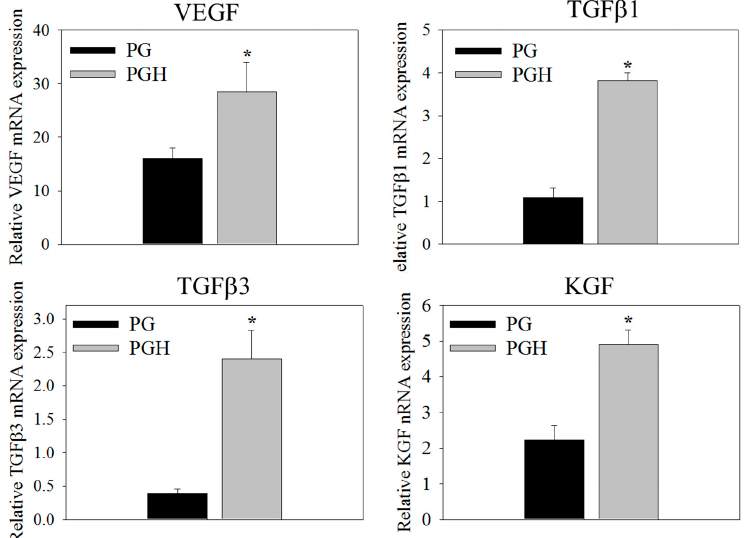
Figure 6. The gene expression analysis of ASCs cultured in PG or PGH FMS for 7 days in vitro. The relative mRNA of vascular endothelium growth factor (VEGF), transforming growth factor- β 1 (TGF- β 1), transforming growth factor- β 3 (TGF- β 3), and keratinocyte growth factor (KGF) was analyzed by quantitative real-time polymerase chain reaction (qRT-PCR). * p < 0.05 compared with PG.